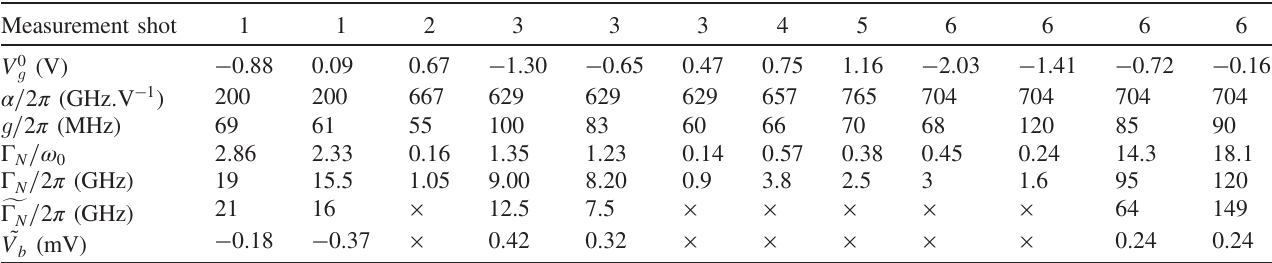
TABLE I. Parameters corresponding to the different N-dot resonances shown in Fig. 7. We first show the effective gate voltage V 0 the lever arm α extracted from the experimental data, and the fitting parameters Γ We also show, when possible, the value of the N-dot tunnel rate ~ V > Δ =e . Each block in the table corresponds to the one shot measurement of a given gate voltage range. The signals Δ φ , for a voltage b Δ A , and G were measured simultaneously in each measurement shot.